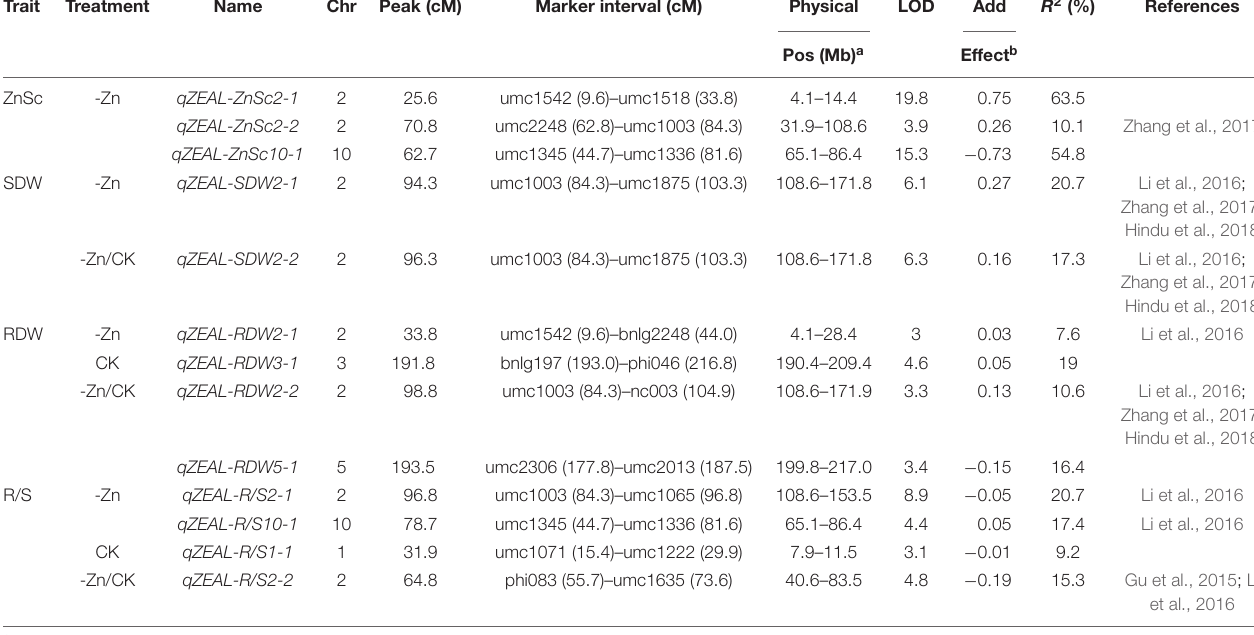
TABLE 2 | Quantitative trait loci for traits associated with Zn deficiency tolerance. Trait Treatment